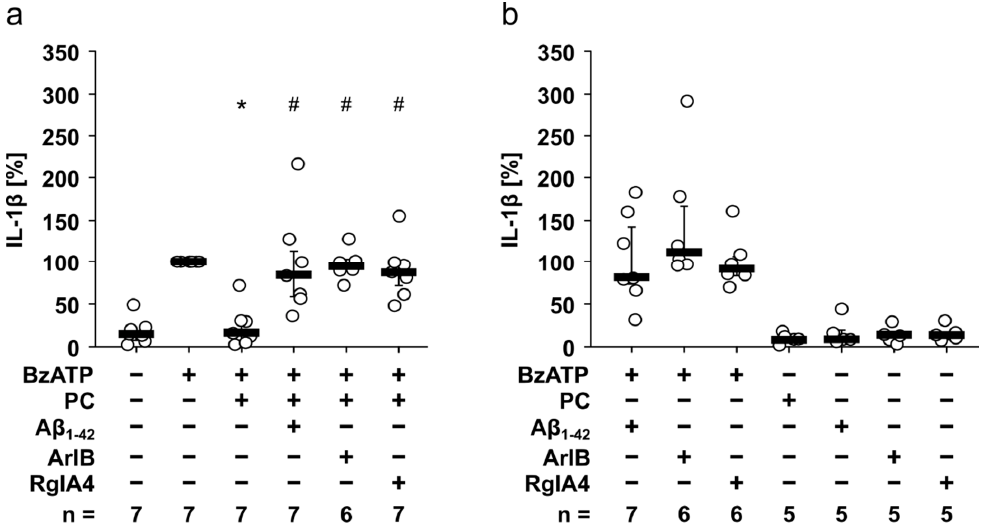
Figure 3. Amyloid beta peptide (A β 1-42 ) attenuates the inhibitory effect of phosphocholine (PC) on